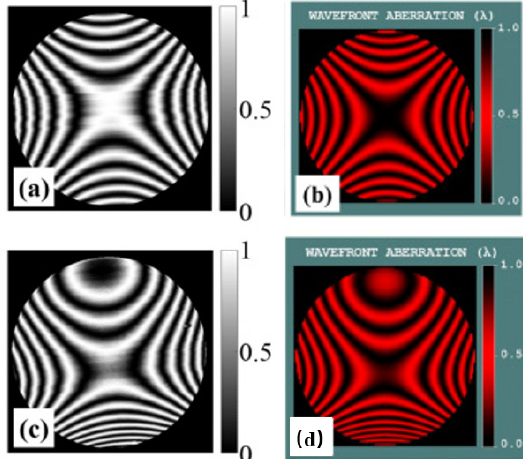
Figure 12. On the left, ( a , c ) are the experimentally obtained interferograms of the equal-along- projection grating and the equal-along-arc grating. On the right, ( b , d ) are the expected interferograms of the equal-along-projection grating and the equal-along-arc grating [62].